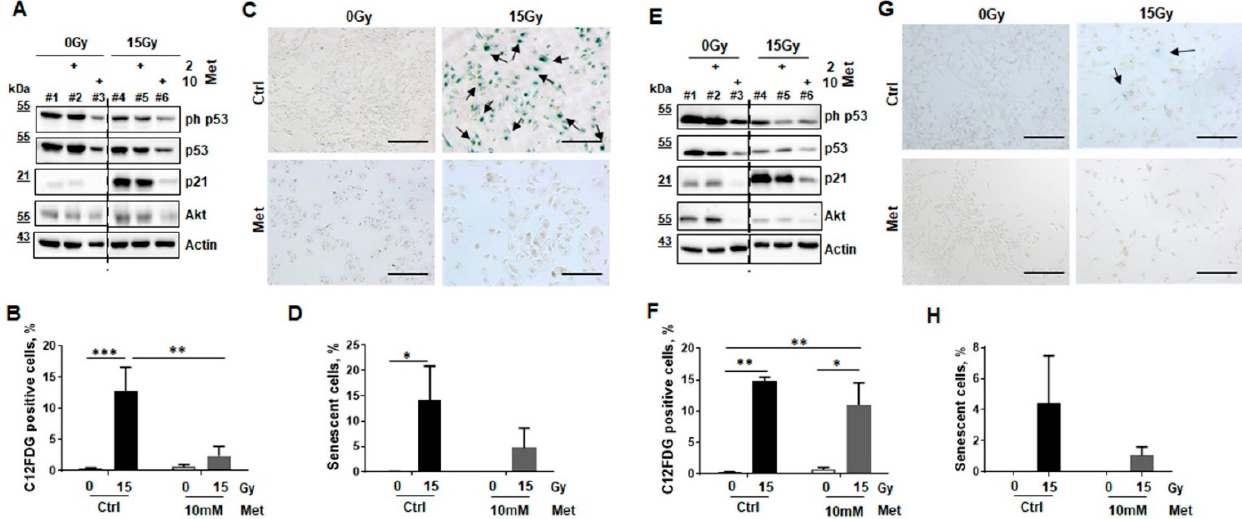
Figure 5. Metformin treatment prevents RT-induced senescence in normal epithelial lung cell cultures. The impact of metformin treatment for RT-induced senescence formation was investigated in cultures of lung epithelial cell lines derived from normal lung epithelium (BEAS-2B and HSAEC1-KT) by analyzing protein expression levels of senescence markers via Western blot ( A , E ), C12FDG staining and flow cytometry ( B , F ), and SA-betagal activity staining ( C , D , G , H ). p21 and p53 expression levels and respective levels of the cell survival marker AKT/PKB were analyzed by Western Blots at 96 h post RT and treatment in BEAS-2B ( A ) and HSAEC1-KT ( E ) cells. Representative blots of 3 independent experiments are shown. Dashed lines indicate different areas of the same blot. Radiation-induced senescence formation was analyzed by C12FDG treatment prior flow cytometric analyses in BEAS-2B ( B ) and HSAEC1-KT ( F ), eight days post treatment. Data showed mean values ±SEM of six independent experiments. p -values indicate: * p ≤ 0.05, ** p ≤ 0.01, *** p ≤ 0.001 by two-way ANOVA with post hoc Tukey’s multiple comparison test. Following SA-betagal activity staining, senescent BEAS-2B ( C ) and HSAEC1-KT ( G ) cells were visualized in in blue. Representative pictures are shown (scale bar: 200 µm). ( D , H ) Senescence formation was quantified by counting the numbers of SA-betagal-positive and -negative epithelial cells. Data showed mean values ±SEM of 3–5 independent experiments. p -value indicates: * p ≤ 0.05 by two-way ANOVA with Tukey’s multiple comparison test.